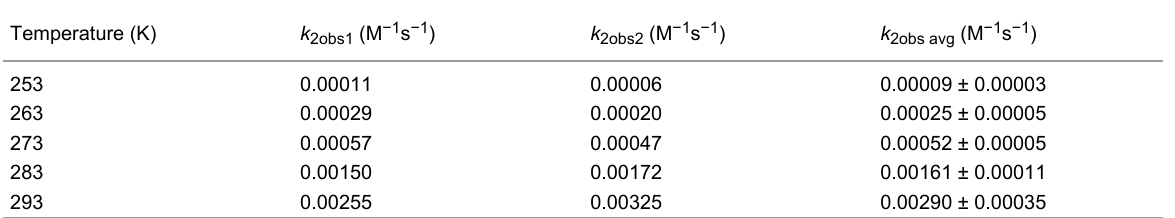
Table 4: Second-order rate constants at 253 K to 293 K for the addition of TMSCN to benzaldehyde. a